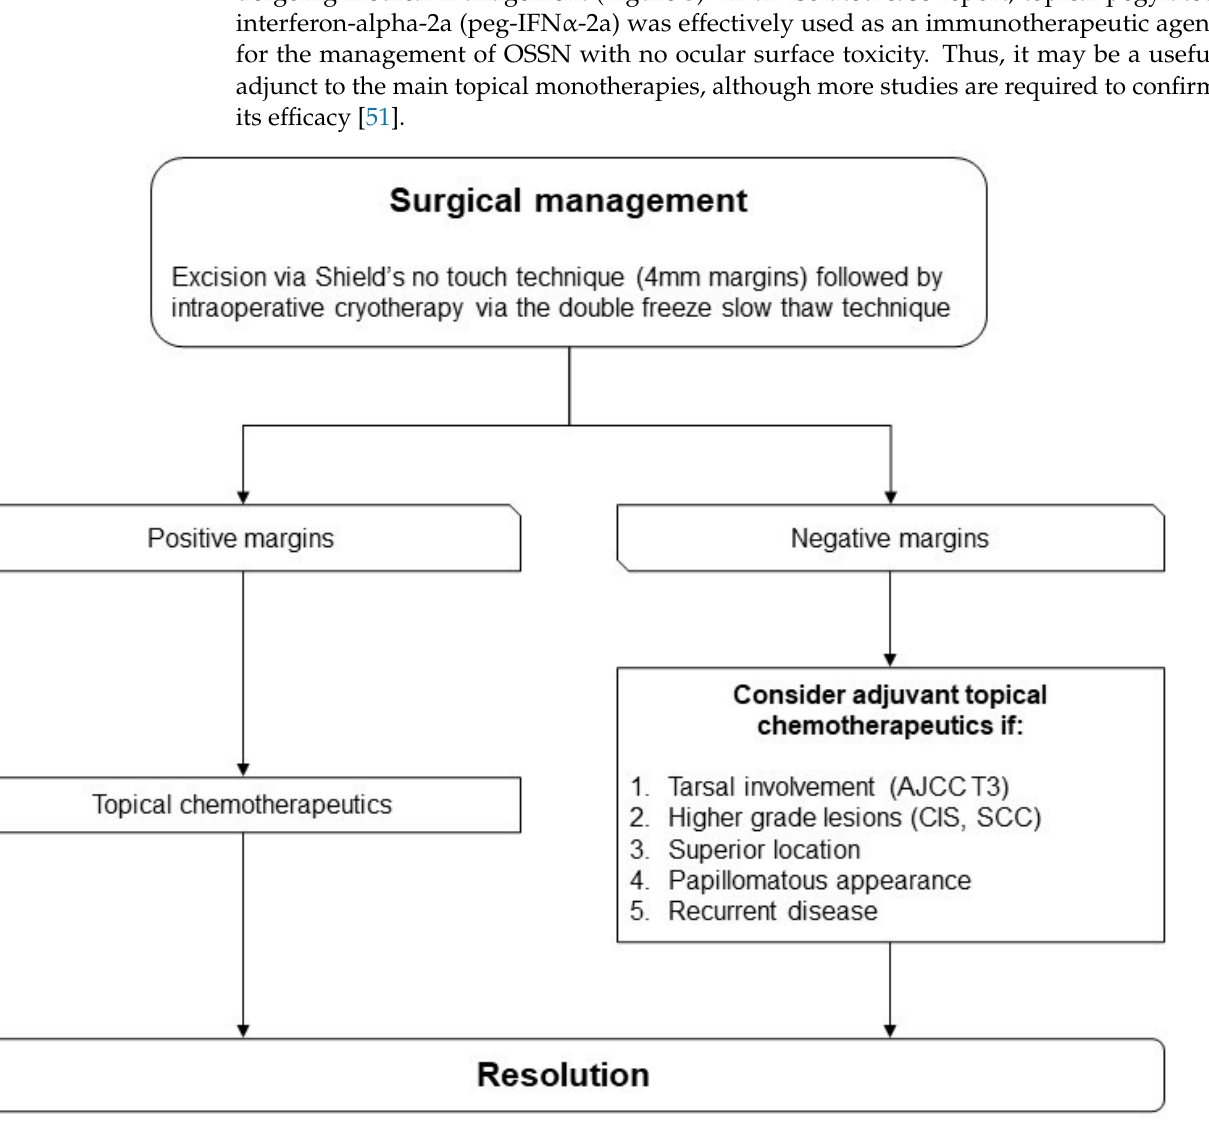
Figure 2. Flowchart guiding the choice of adjuvant topical chemotherapy following surgical manage- ment of OSSN.